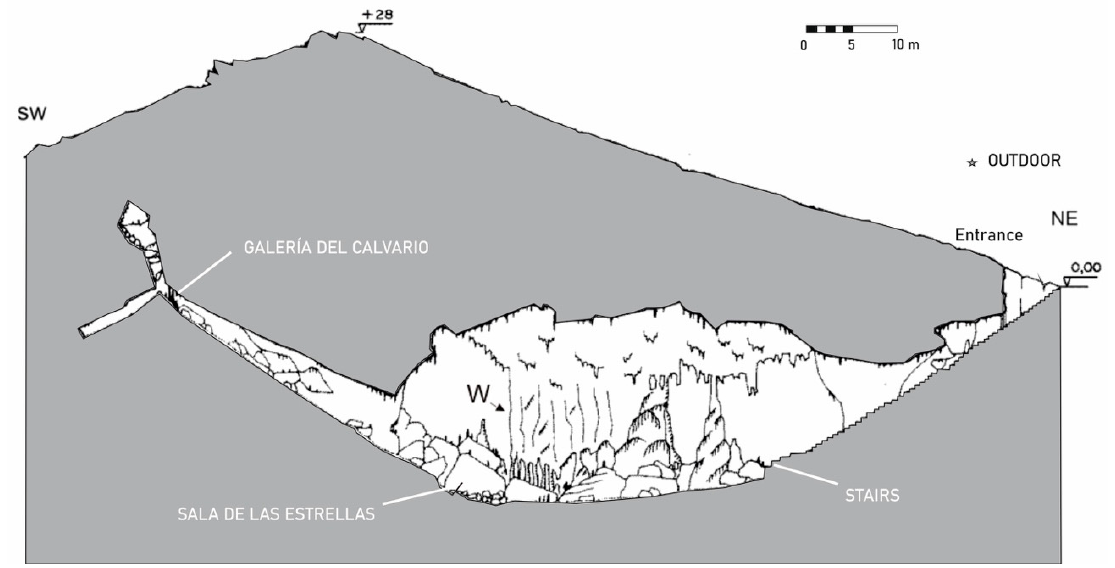
Figure 1. Cross section of Cueva de Ardales and locations of the aerobiological sampling points.